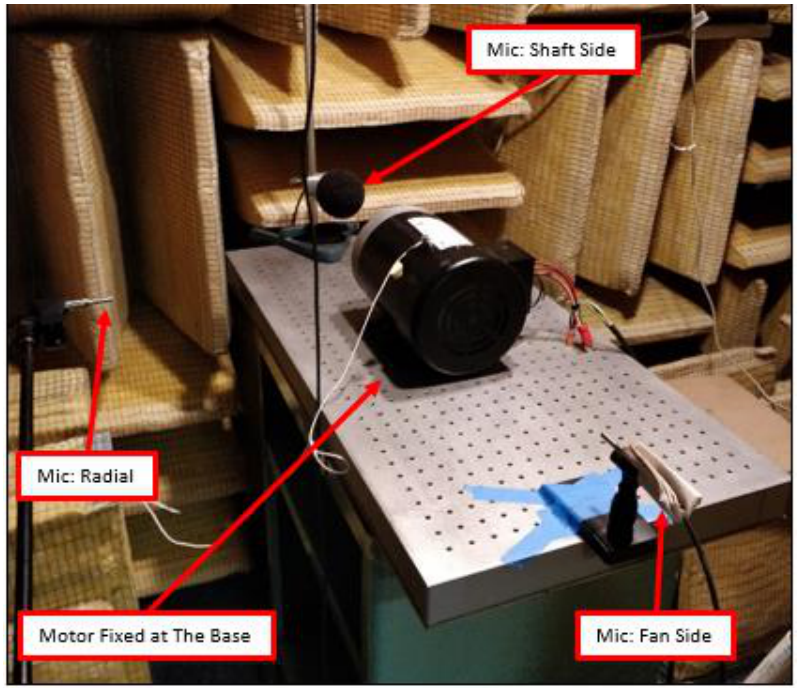
Figure 2. Acoustic measurement setup in the semi-anechoic chamber.